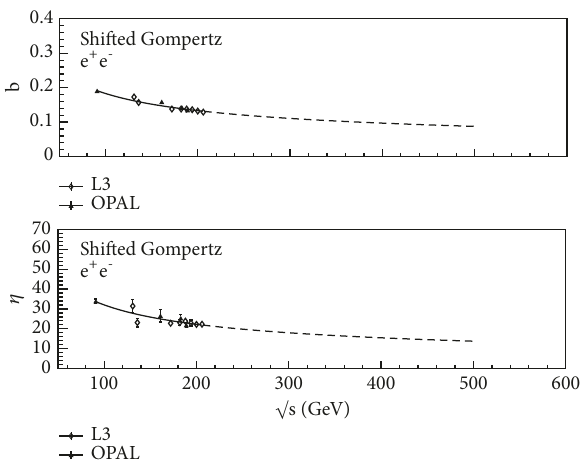
Figure 9: Scale parameter 𝑏 and shape parameter 𝜂 for 𝑒 + 𝑒 − data. Pointsrepresentthedata;solidlineisthepowerlawfitandthedotted line the extension of power law fit.